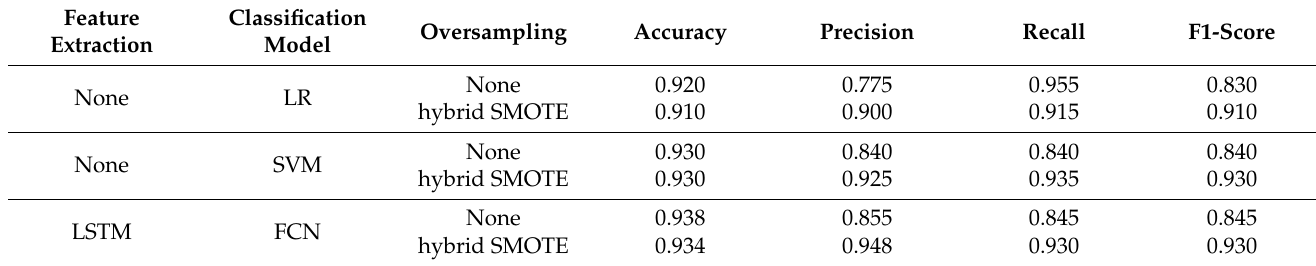
Table 3. Summary of the baseline model’s performance using a 16-week-wise data